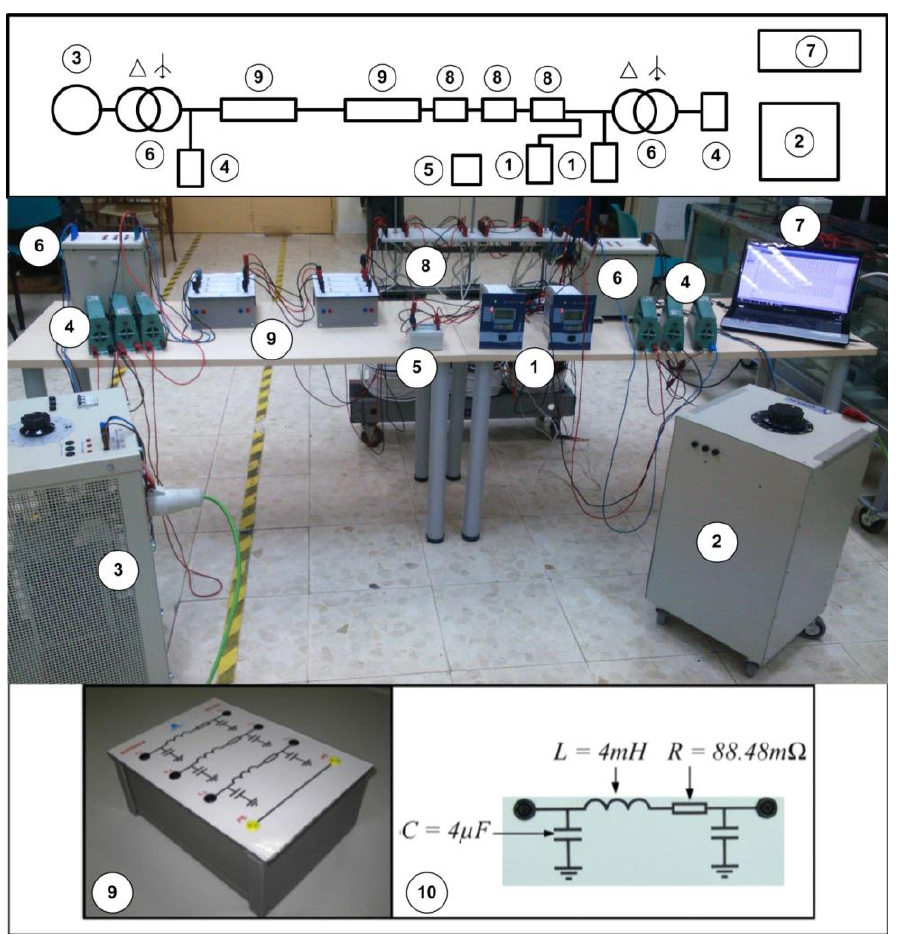
Figure 14. Experimental setup. 1: Protection relays; 2: Auxiliary power supply; 3: Power supply; 4: Loads; 5: Ground fault switch; 6: Transformer; 7: PC; 8: Cables; 9: Line modules; 10: RLC parameters of the line modules (9) used.